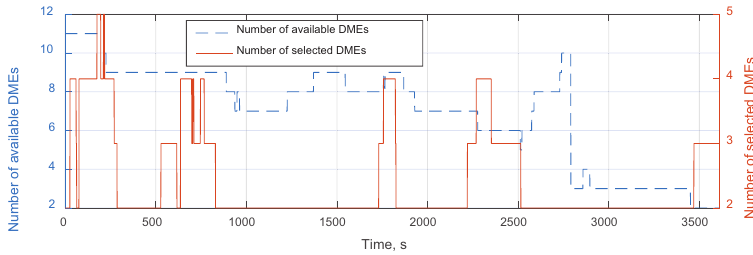
Figure 9. Number of DMEs in multi DME/DMEs approach